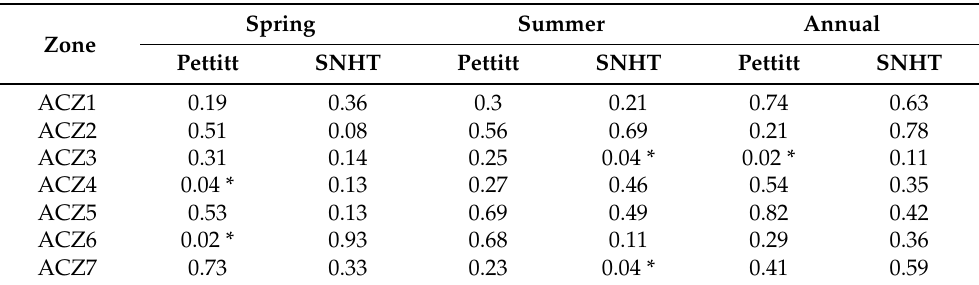
Table 2. Summary of homogeneity test